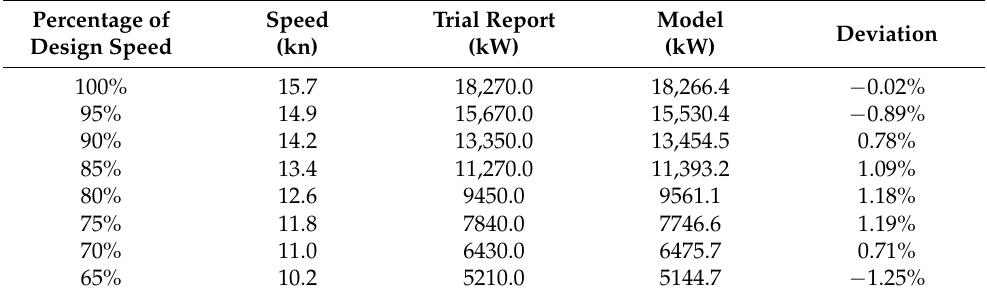
Table 5. Trial and simulation results of main-engine power.